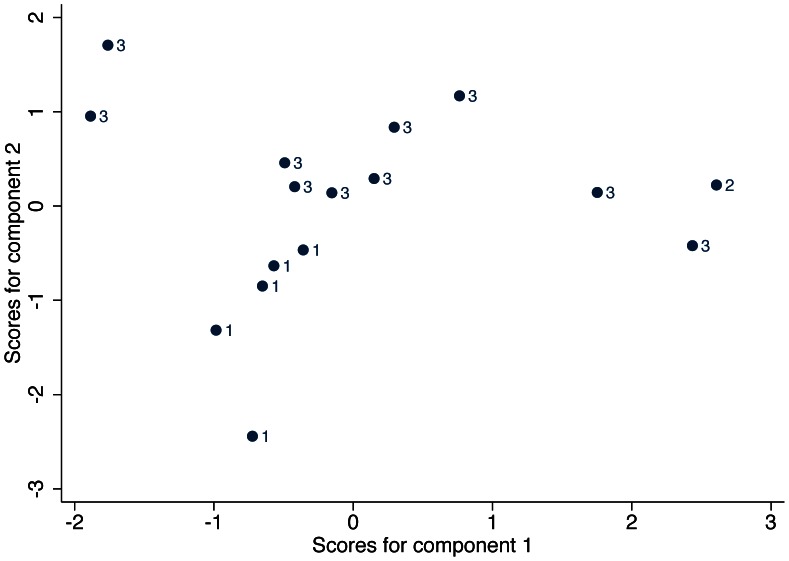
Principal components analysis of the human isotope data (δ13C, δ15N.
and 87Sr/86Sr ratios).